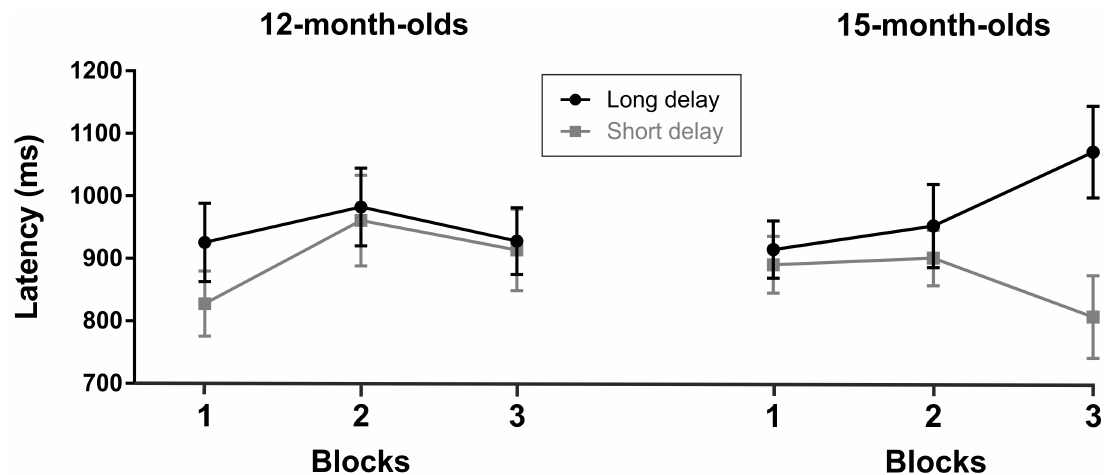
Fig 2. Percentage of total looking time (PTLT) at correctside during the inter-stimulus-interval (ISI) for each age group in each of the three blocks. Bars indicatestandard error of the mean.